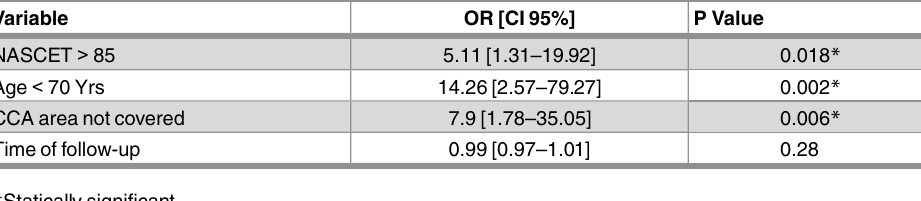
Table 5. Independentpredictorsof